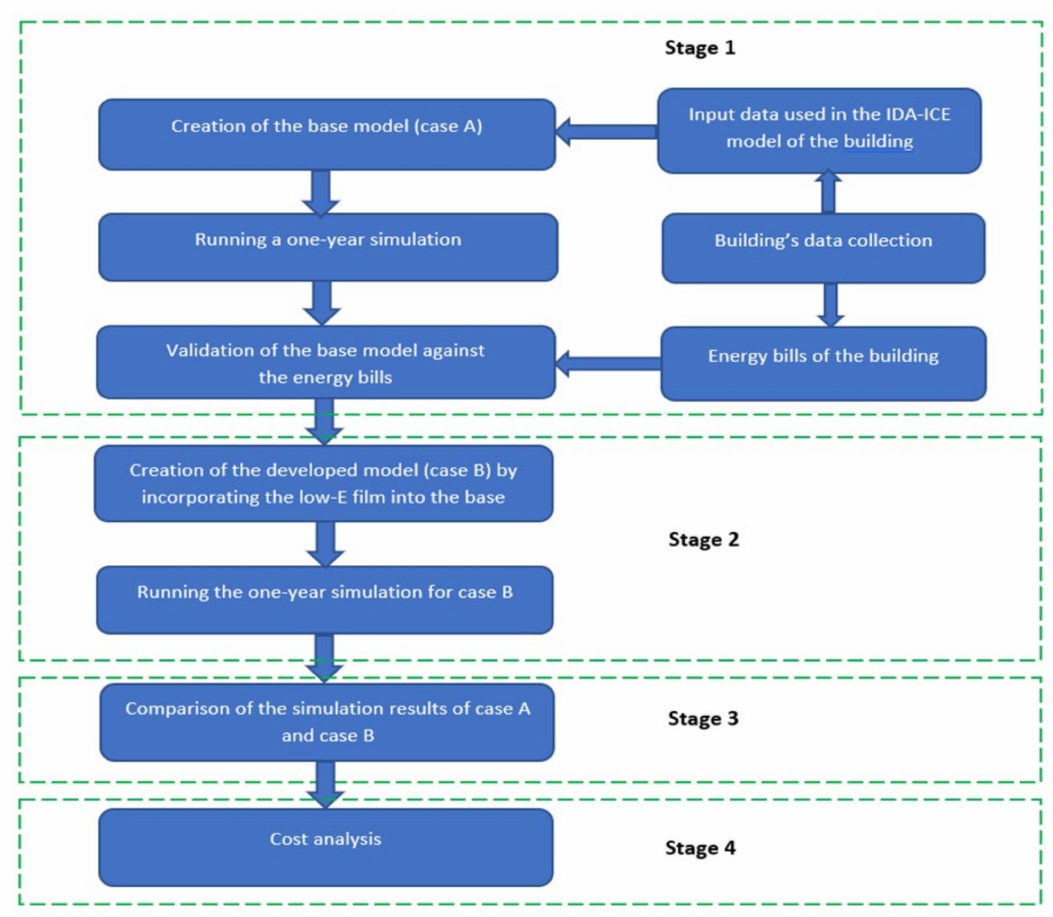
Figure 4. Overview of the research process.